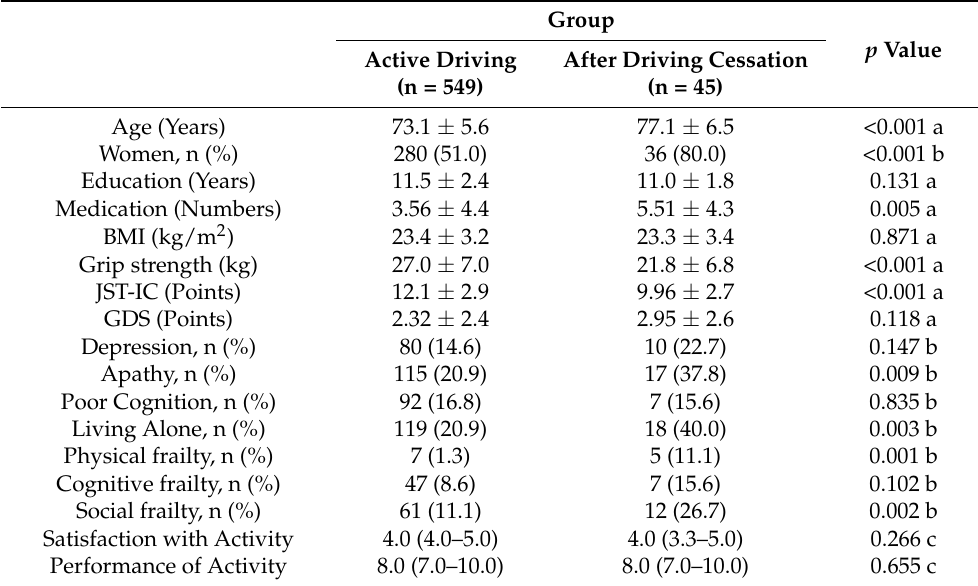
Table 1. Comparison of characteristics between the active driving and the after driving cessation group in all the participants.